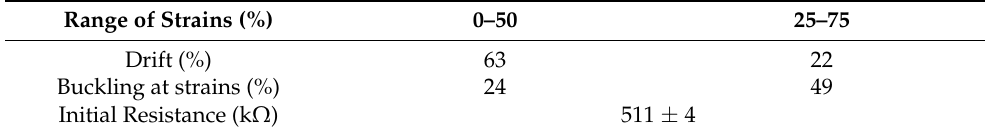
Table 3. Characteristic values of the electrical sensor performance derived from the dynamic tensile testing of the ShSFC. The initial resistance was calculated as the mean value from five